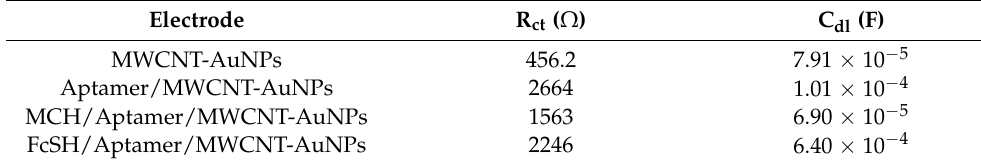
Table 1. Equivalent circuit parameters i.e., R ct and C dl for the measured